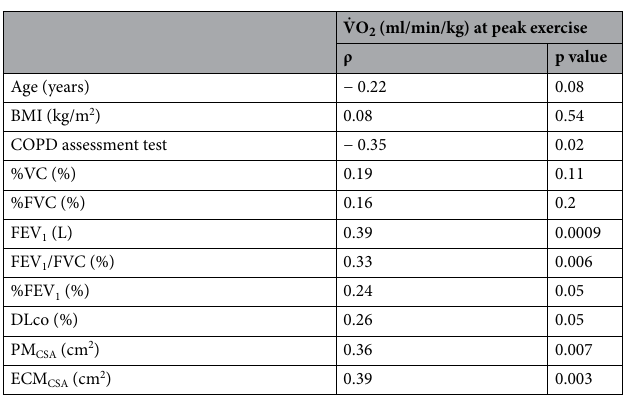
˙ VO Table 4. Correlation coefficients between 2 at peak exercise and clinical parameters of COPD including ˙ VO skeletal muscle area. CPET Cardiopulmonary exercise testing, 2 oxygen uptake, BMI; body mass index, COPD chronic obstructive pulmonary disease, VC vital capacity, FVC forced vital capacity, FEV 1 forced expiratory volume in 1 s, DLco diffusing capacity of lung for carbon monoxide, PM CSA cross-sectional area of pectoralis muscles, ECM CSA cross-sectional area of erector spinae muscles.